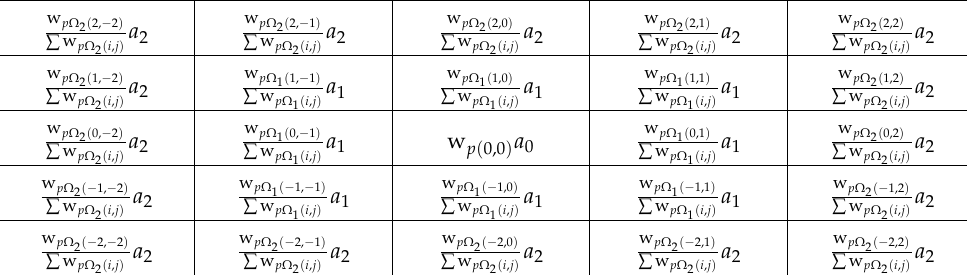
Table 4. Intensity domain fractional differential